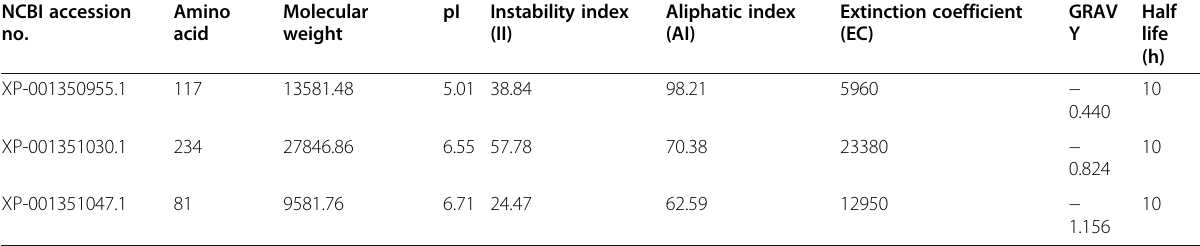
Table 3 Physicochemical properties of the hypothetical proteins of Plasmodium falciparum NCBI accession